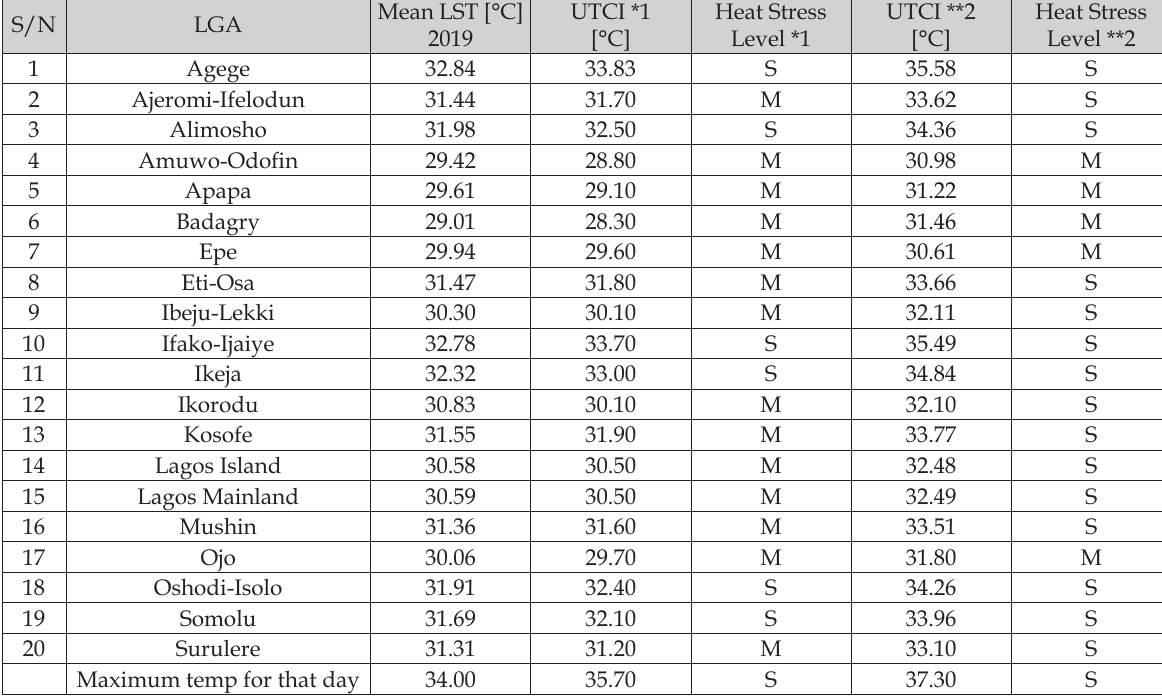
Fig. 11. Heat stress map for Lagos State on 30 January 2019 with mean LST. a – UTCI *1 from utci.org; b – UTCI **2 from climatechip.org. Table 5. UTCI heat stress index with LST for Lagos State on January 30,